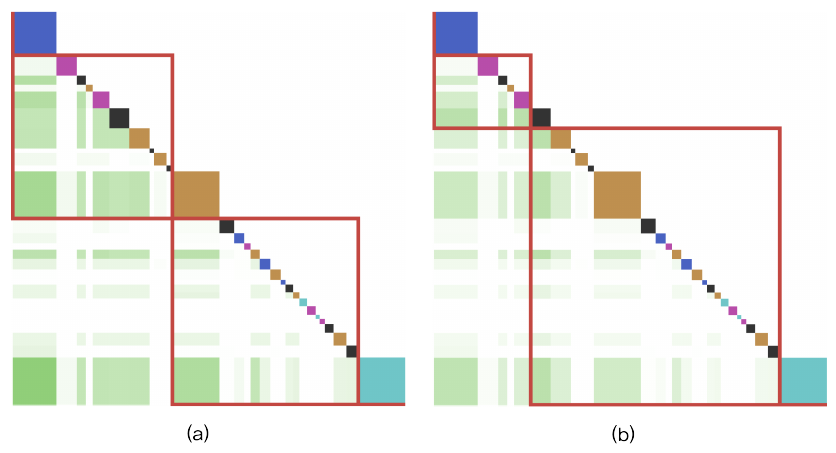
Figure 14. Before ( a ) and after ( b ) topic guide of moderator is applied to conceptual similarities. By applying the weight of the metric that quantifies the topic guide of moderator, the transcript is segmented based on the corresponding conceptual similarities including moderator’s